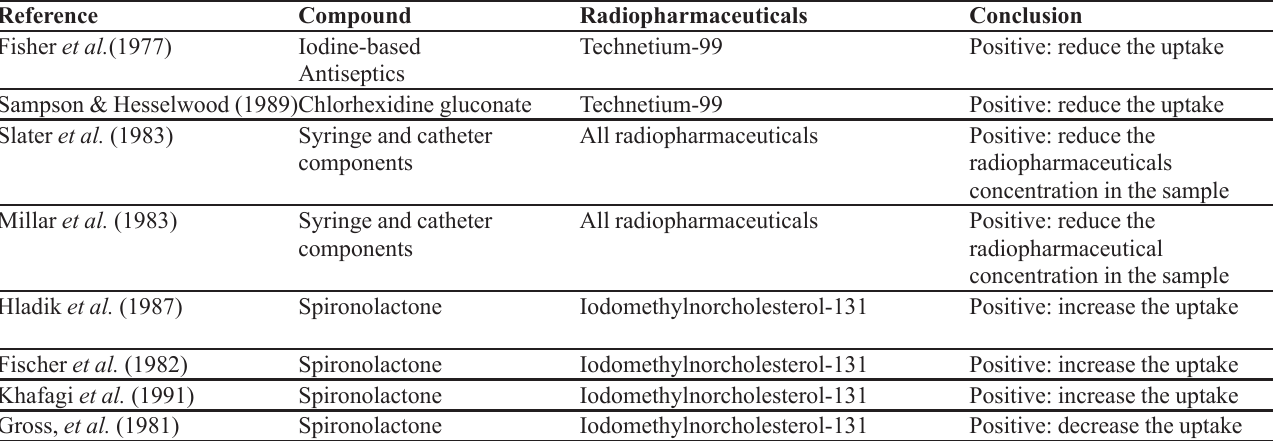
TABLE I – Summary of the compounds that might interfere with radiopharmaceuticals